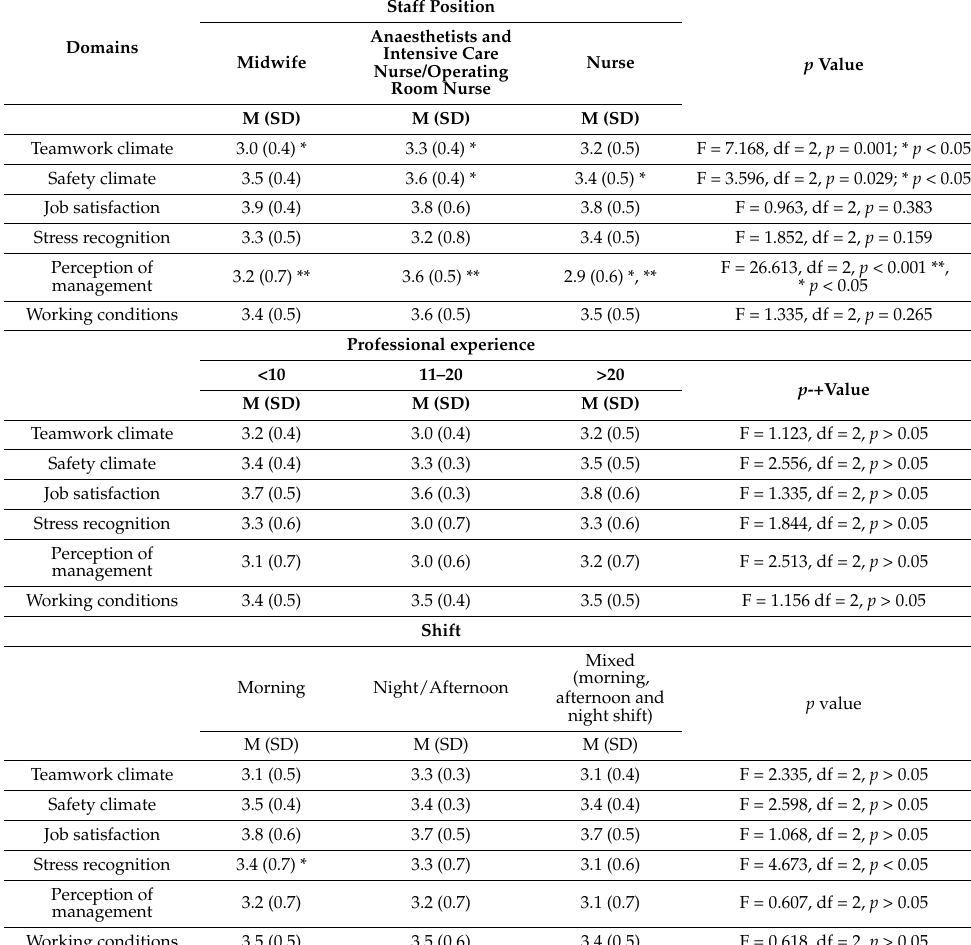
Table 5. SAQ factor evaluation by sociodemographic and professional characteristics. Domains